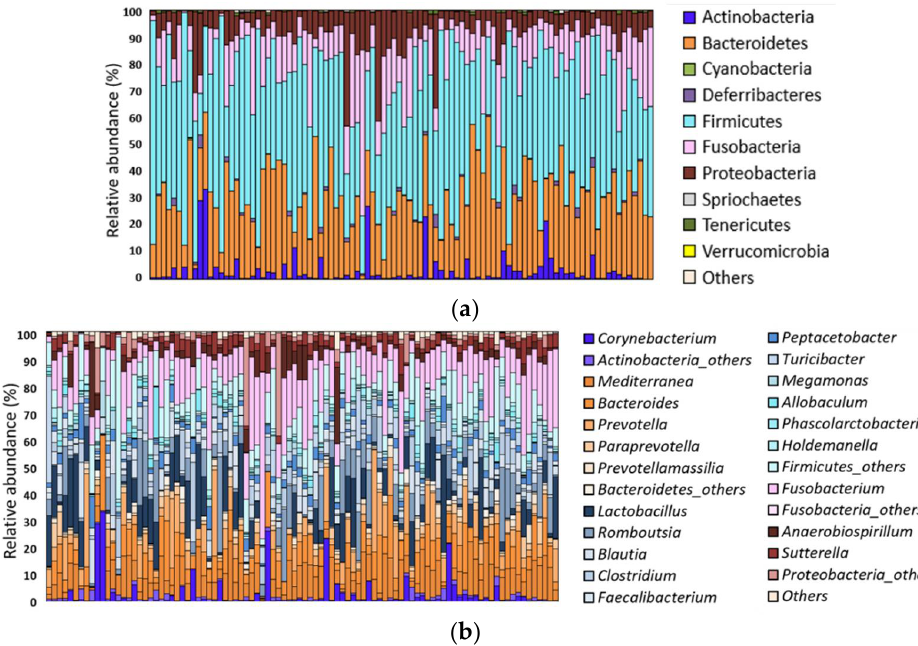
Figure 1. Overall gut microbial composition of 96 healthy dogs. Relative abundances of ( a ) phyla (≥ 0.01% of the total sequences) and ( b ) genera (≥ 1% of the total sequences) from the five major phyla.